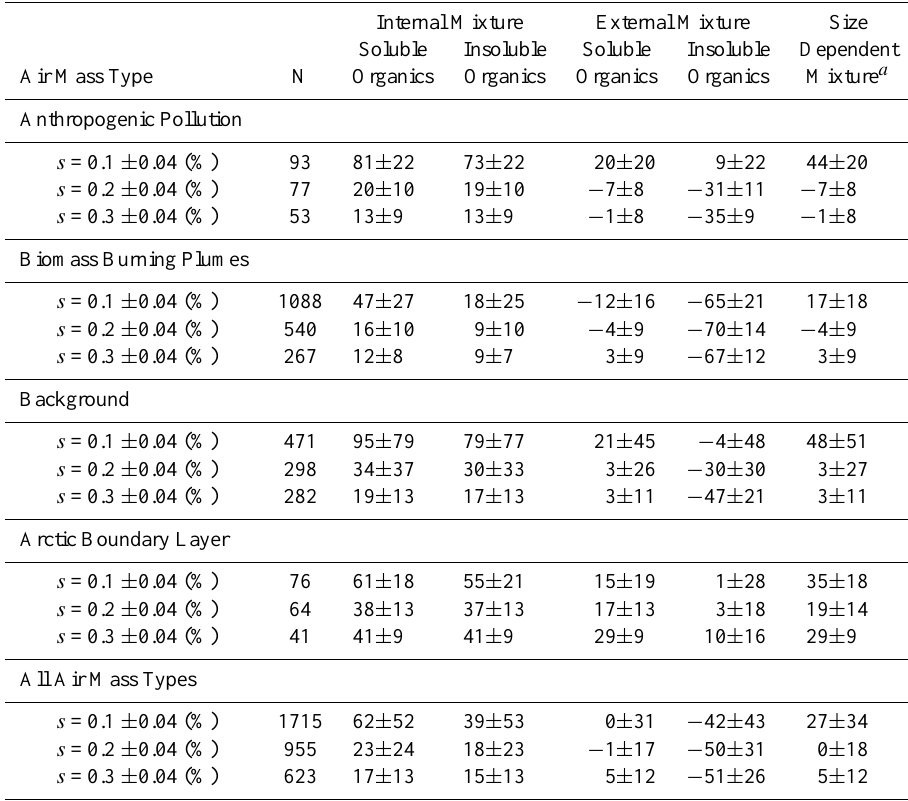
Table 1. Percent overprediction ( 8 − 1) × 100% in CCN number concentration from different organic solubility and mixing state assumptions. Data from the CCNC, C-ToF-AMS, and size distributions were averaged over 10-s periods, and N reflects the number of 0.1-Hz data points used to calculate each mean and standard